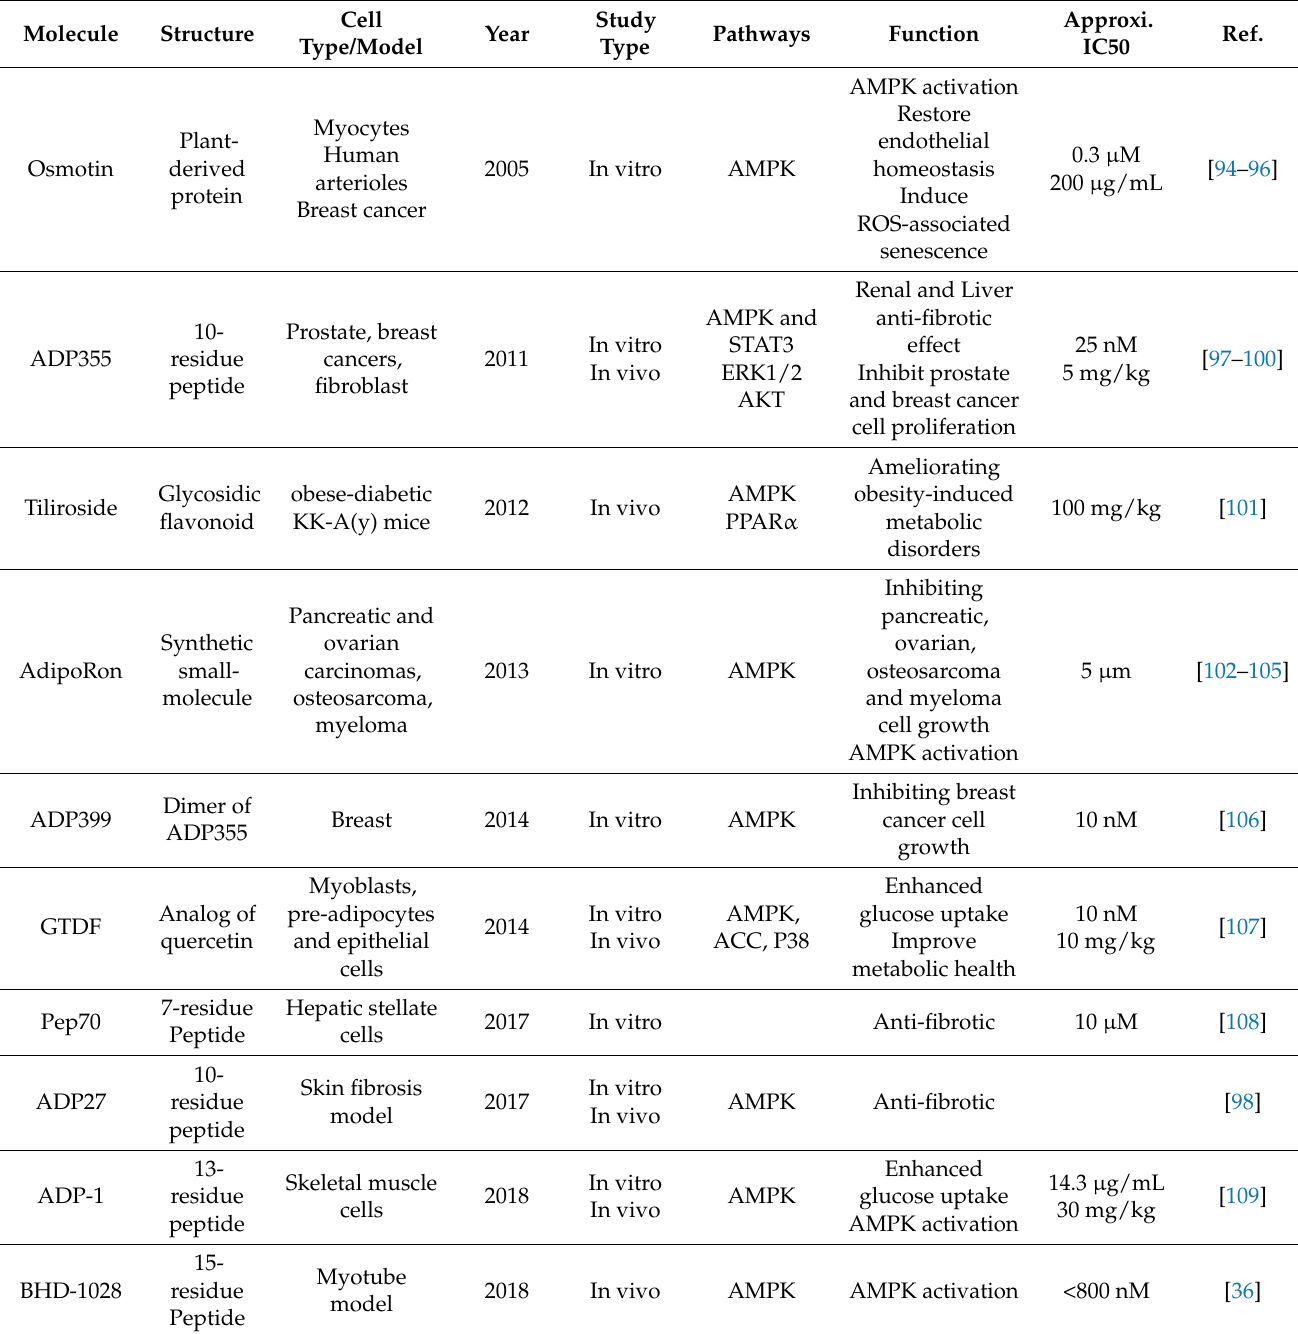
Table 1. List of the main adiponectin receptor agonists found in the literature and their published ac-